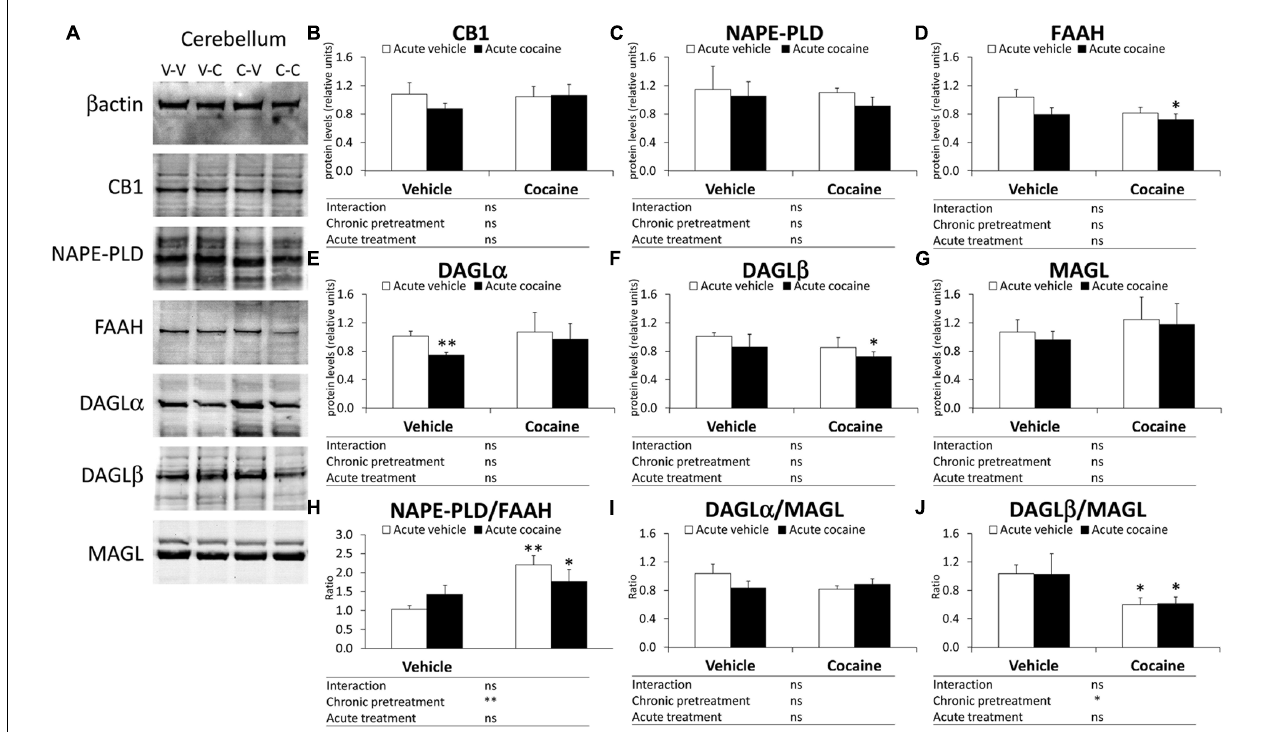
FIGURE 3 | Representative immunoblots (A) and relative protein levels of components of the eCB signaling system [CB1 (B), NAPE-PLD (C), FAAH (D), DAGL α (E), DAGL β (F), MAGL (G), NAPE-PLD (H), DAGL α /MAGL (I), and DAGL β /MAGL (J)] in the mouse cerebellum after chronic